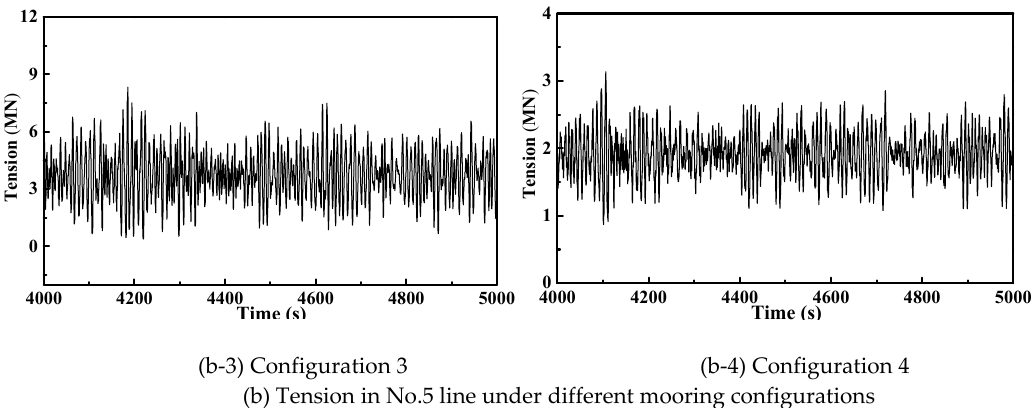
Figure 7. Time series of tension on mooring lines in different mooring configurations.